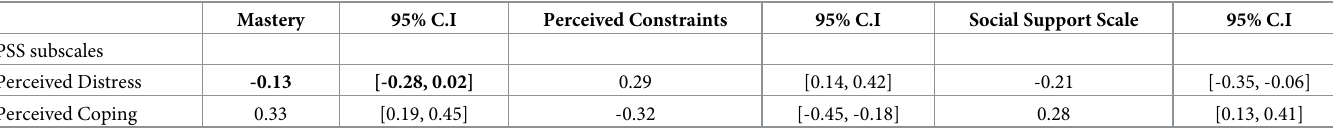
Table 5. Correlations between Perceived Distress and Perceived Coping subscales with Mastery, Perceived Constraints and Social